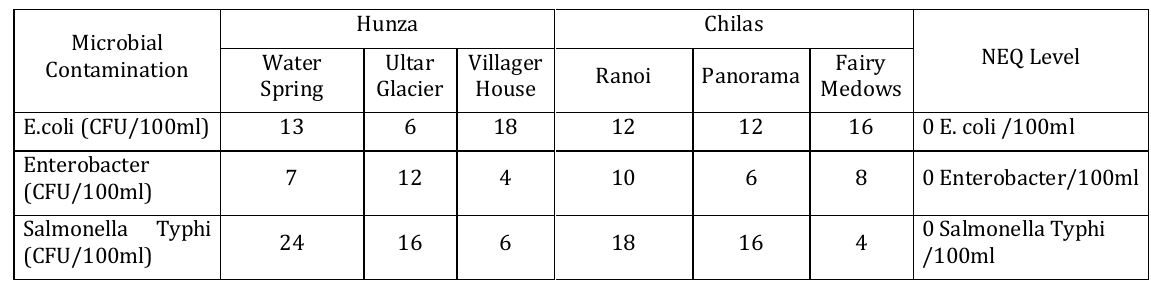
Table 7. Microbial test